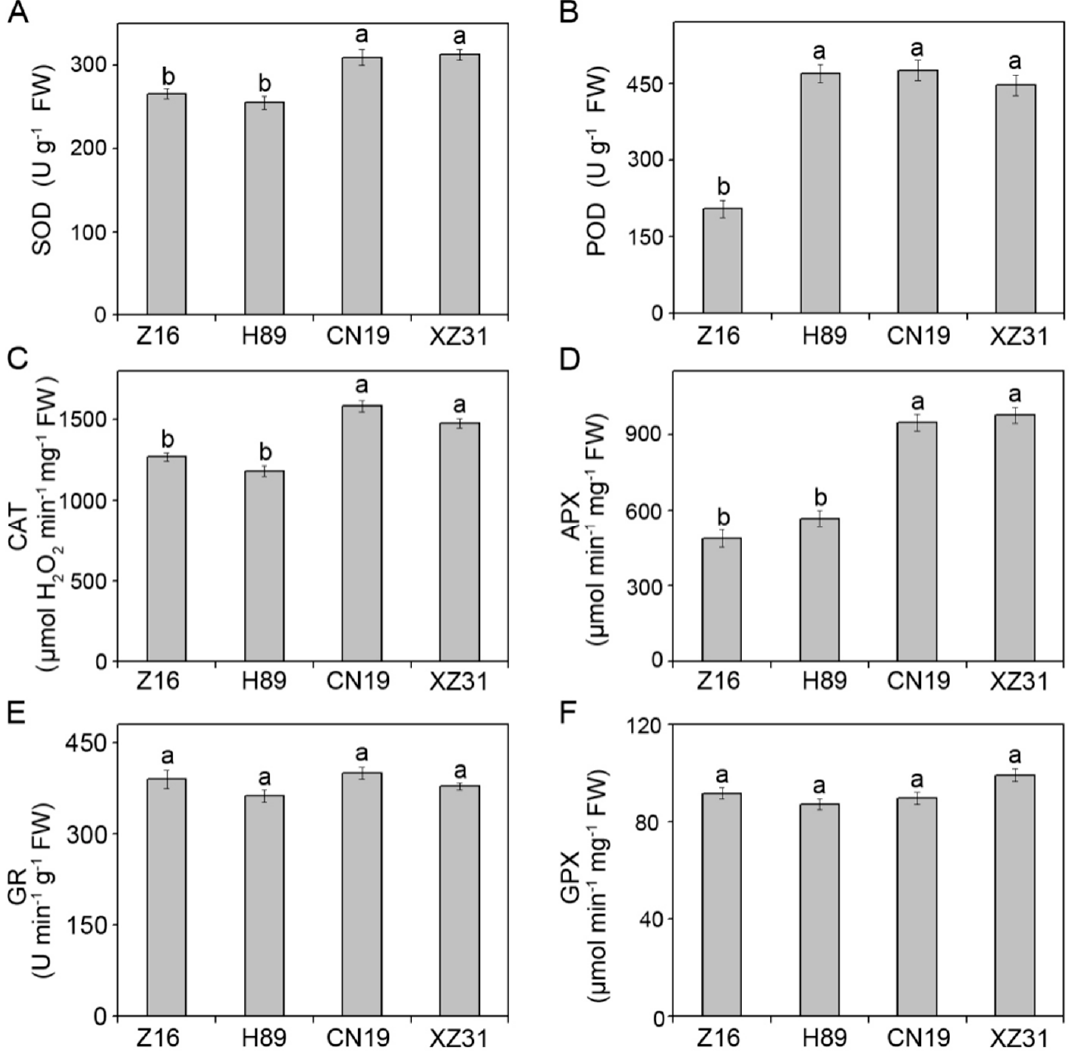
Figure 7. The activities of SOD, superoxide dismutase ( A ); POD, peroxidase ( B ); CAT, catalase; ( C ); APX, ascorbate peroxidase ( D ); GR, glutathione reductase ( E ); and GPX, glutathione peroxidase ( F ) in Z16, H89, CN19, and XZ31. Values are expressed as the means ± SD ( n = 4). Different letters indicate significant differences at p < 0.05 level (Duncan’s multiple range test). Z16, H89, CN19, and XZ31 present accessions of Triticum monococcum (W2n), Triticum dicoccum (W4n), Triticum aestivum (W6n), and octaploid Triticale (T8n), respectively. The differences in photosynthetic capacity are usually involved in the levels of thylakoid membrane proteins in plants. Therefore, the differences in the levels of PSI and PSII proteins were further analyzed by immunoblotting among Z16, H89, CN19 and XZ31 (Figure 8). Except for D1, PsaD and Lhcb4, almost no detectable changes in the amount of almost all the analyzed thylakoid membrane proteins were observed among Z16, H89, CN19, and XZ31 (Figure 8A). Interestingly, the levels of D1, PsaD, and Lhcb4 proteins showed significant decreases in Z16 compared to H89, CN19 and XZ31 (Figure 8A and Figure